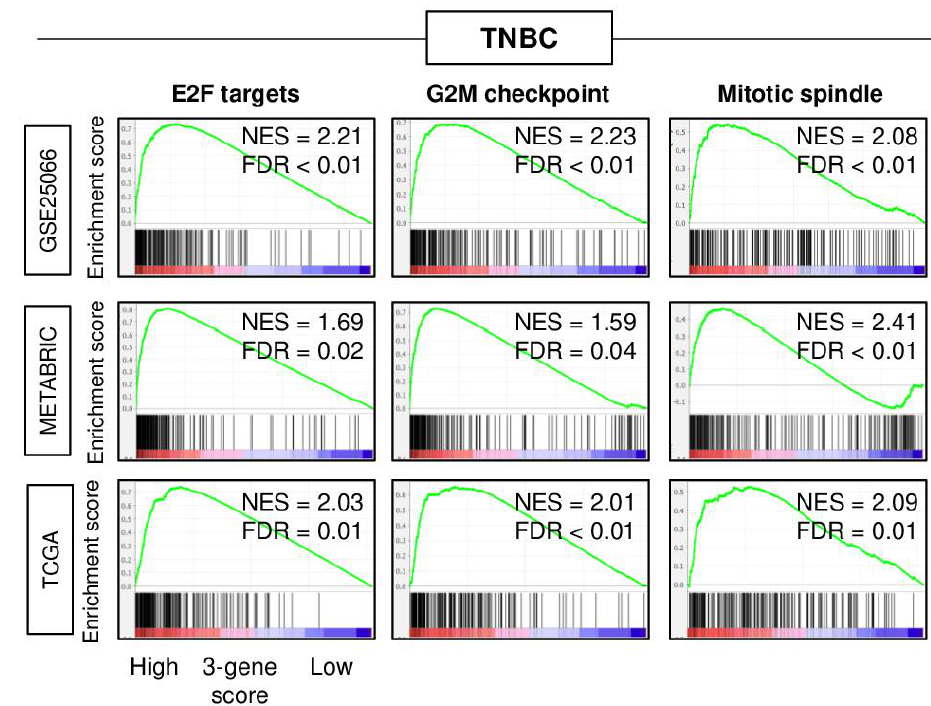
Figure 3. Gene set enrichment analysis (GSEA) of high 3-gene score triple-negative breast cancer (TNBC) in the GSE25066, METABRIC, and TCGA cohorts. Enrichment plots of hallmark E2F tar- gets, G2M checkpoints, and mitotic spindle gene sets in the GSE25066, METABRIC, and TCGA cohorts superimposed with a normalized enrichment score (NES) and false discovery rate (FDR) are shown. NES and FDR were determined with the classical GSEA method, where FDR < 0.25 is considered significant.